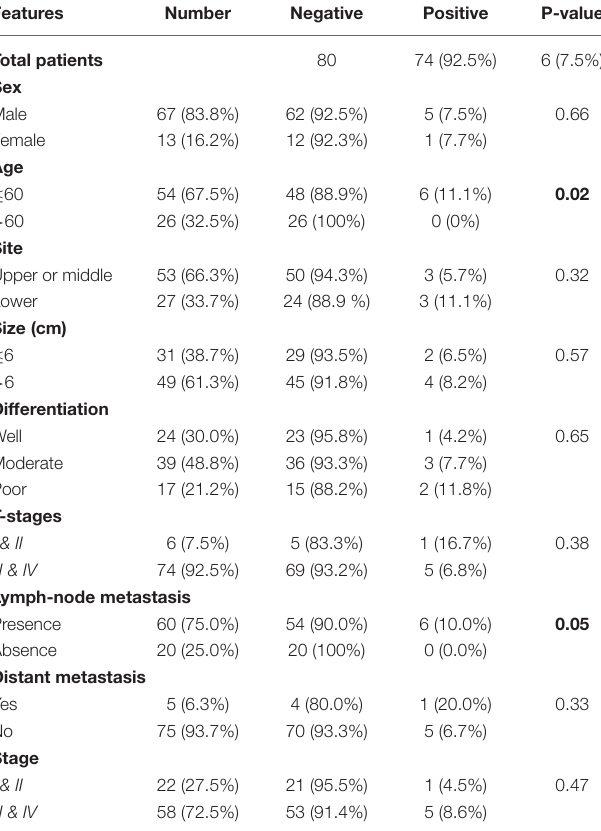
TABLE 2 | Correlation of EPAS1 mutations with clinicopathological features of patients with esophageal squamous cell carcinoma. Features